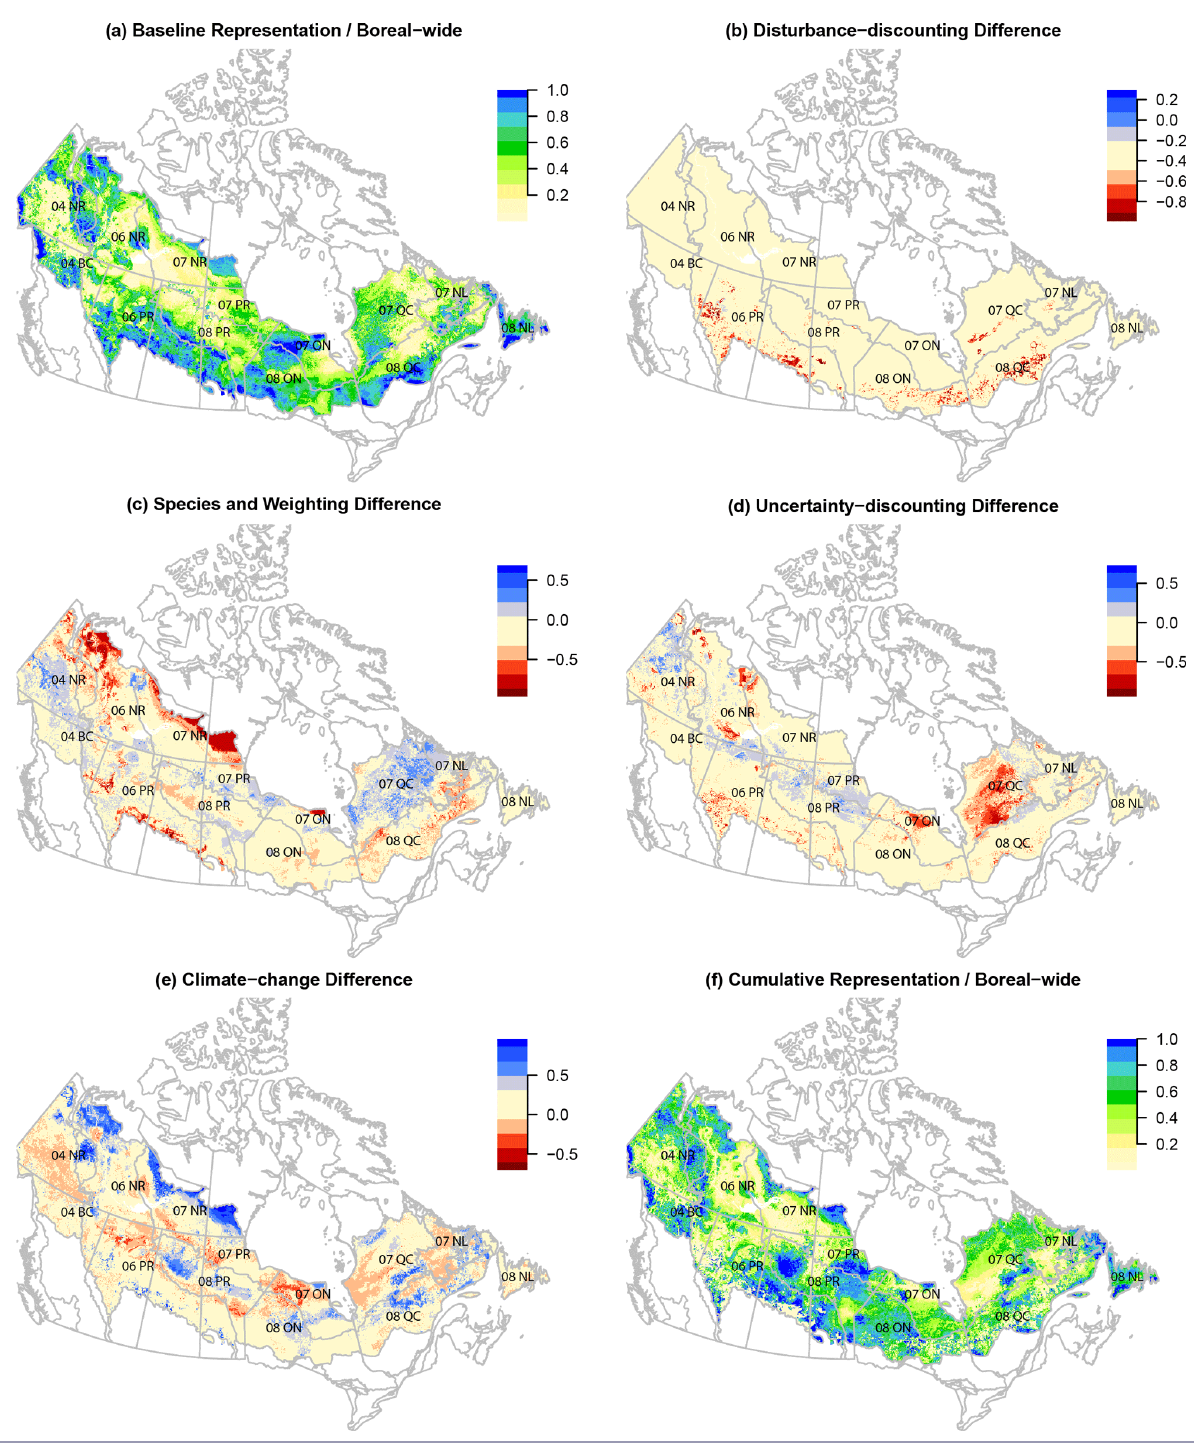
Fig. 8 . Comparison among (a) baseline boreal-wide, species representation-focused rankings (scenario 1) and sequential influences of (b) disturbance-discounting, (c) forest species and priority weighting, (d) uncertainty discounting, and (e) midcentury climate change, respectively; (f) cumulative solution (scenario 46). Highest Zonation ranks are in dark blue; lowest ranks are in yellow. Blue indicates higher rank than comparison scenario; red indicates lower